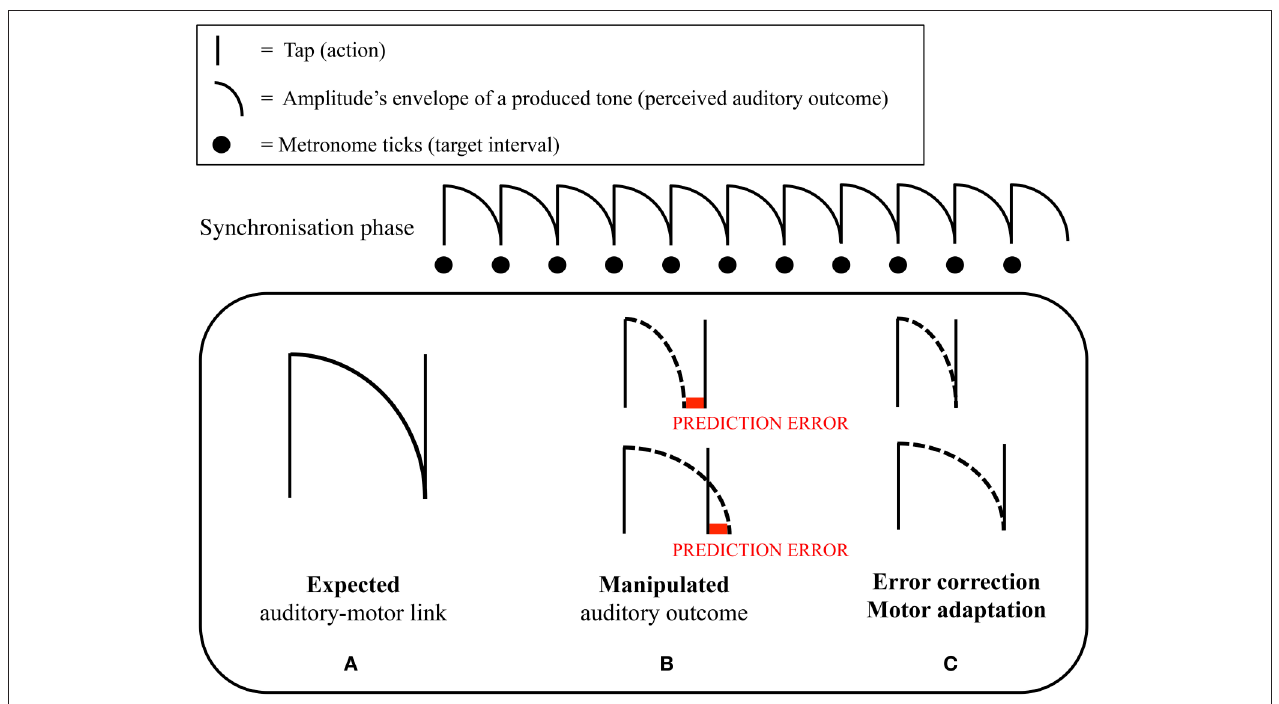
FIGURE 1 | Graphical representation of the mechanism of motor adaptation in Maes et al. (2015a). Participants were asked to perform a synchronization-continuation task. (A) Representation of the relationship between the target interval between two taps, and the amplitude’s envelope of the tone that was produced by a tap. As can be seen, a tone nicely fitted the target interval. In the synchronization phase of the continuation paradigm, people learned to integrate the (fixed) tones’ duration (perception), with the target interval that needed to be tapped (action) through repeated experience. (B) We hypothesized that participants could use the tone’s amplitude’s envelope as a reference to time their tapping; namely, one tapped at the moment that the previous tone ceased (i.e., sensorimotor timing strategy). Throughout the continuation phase, we gradually lengthened or shortened the duration of the produced tones. (C) We hypothesized that, if participants relied on a sensorimotor strategy, they would adapt their tapping pace when the tones’ duration became longer or shorter throughout the continuation phase. This because of the discrepancy that appeared between the ceasing of the tone, and the time a tap was produced. Correspondingly, we expected that participants would change their tapping pace in order to avoid this discrepancy to occur. Maes et al. (2015a) found that a gradual shortening of the tones’ duration resulted in an increased tapping pace. A gradual lengthening did not yield any significant effect in tapping